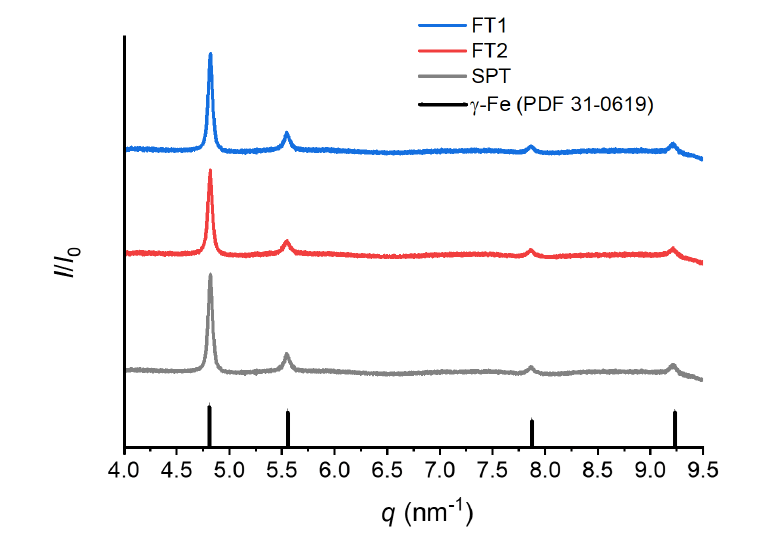
Figure 7. X-ray diffractograms of as-machined FT1, FT2, and SPT in comparison with the standard diffractogram of α -Fe. The diffractograms were obtained on the nut annulus surface in a region close to the